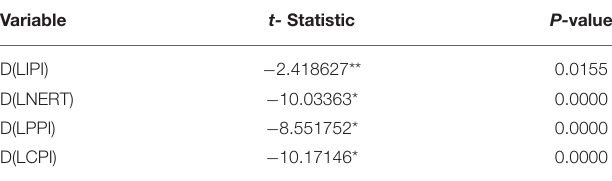
TABLE 1 | Unit root test results.